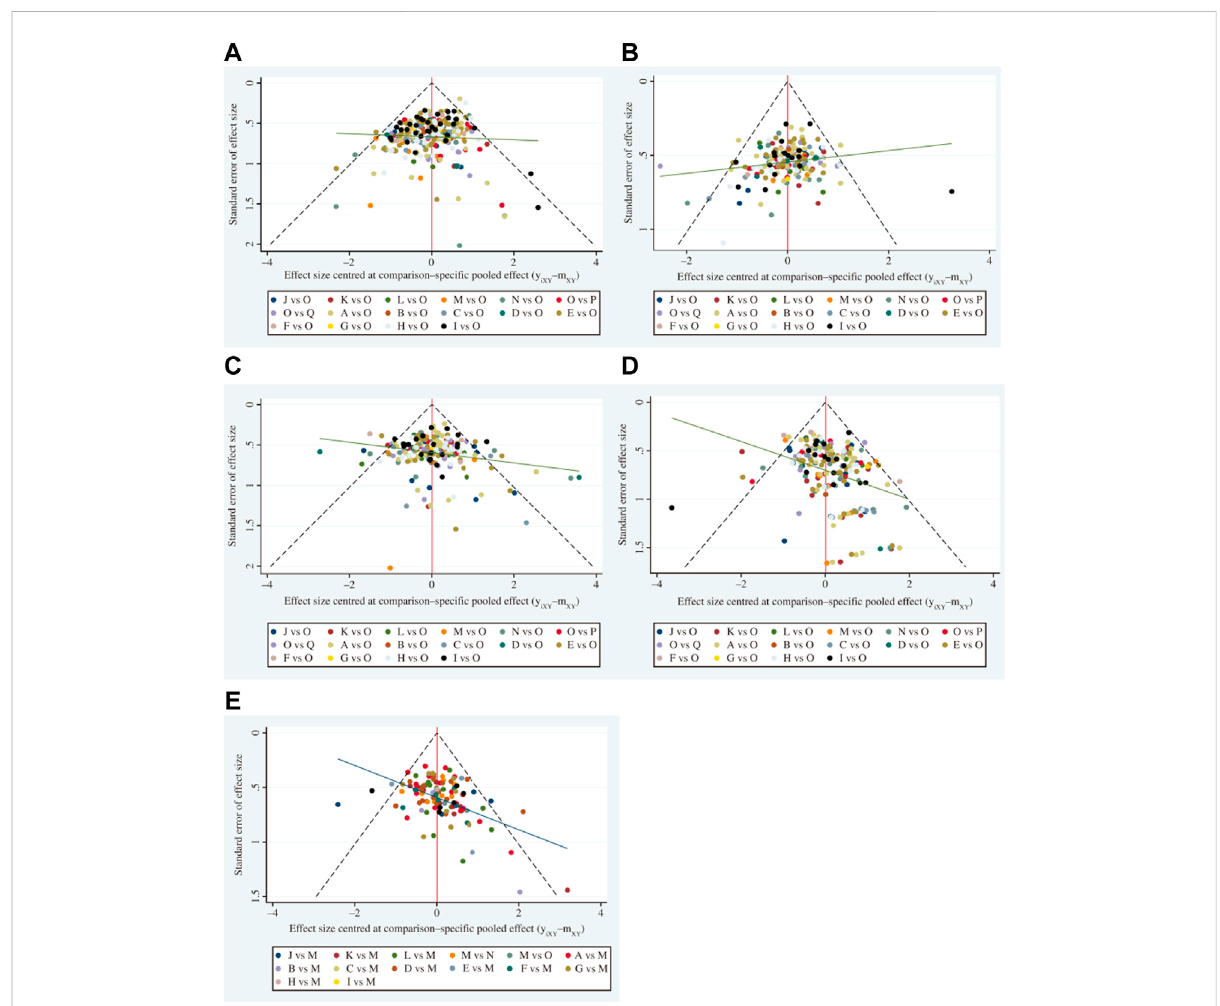
FIGURE 6 Funnelplots(Acomparison-adjustedfunnelplotwasusedtoassesspotentialpublicationbias.Ifpointsonbothsidesofthemidlineinthefunnel diagram were symmetric, which meant the comection guideline was at right angles to the midline, it was considered indicative of no signi fi cant publication bias). (A) Disease control rate. (B) Survival quality score. (C) Incidence of gastrointestinal adverse reactions. (D) Incidence of leukopenia. (E) Incidenceofthrombocytopenia.A,adi+wm;B,csi+wm;C,dci+wm;D,dlsi+wm;E,f fl csi+wm;F,hcsi+wm;G,hqi+wm;H,kai+wm;I, klti + wm; J, oomi + wm; K, s fi + wm; L, si + wm; M, smi + wm; N, sqfzi + wm; 0, win; P, xapi + wm; Q, xgdti +